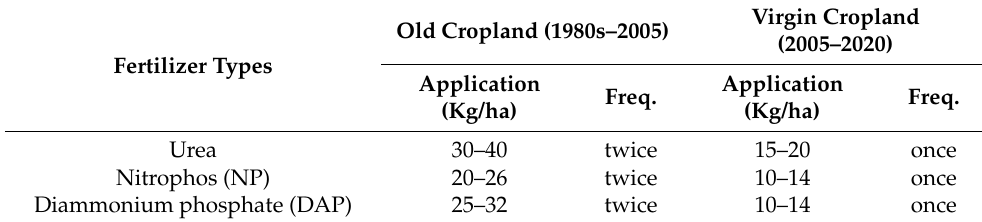
Table 4. Types of agro-chemical inputs and their use